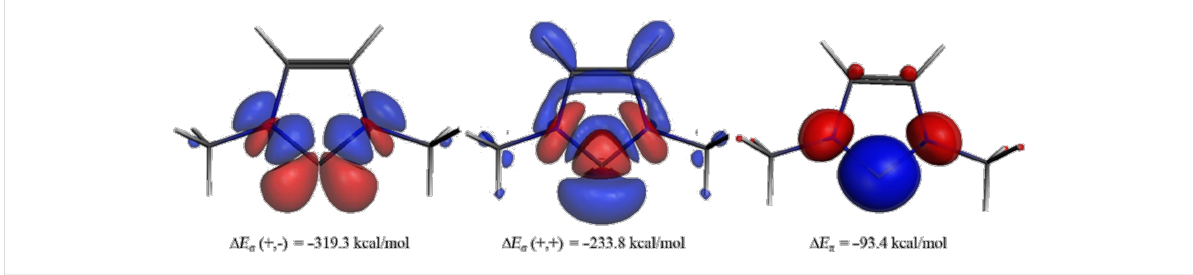
(+, − ) component of the C carb –N σ -bond ( − 319.3 kcal/mol, Figure 3a) is bigger than the ∆ E σ (+,+) component ( − 233.8 kcal/mol, Figure 3b) which can be explained with the larger overlap of the former term (see Scheme 2). Note that the charge flows of the individual (+,+) and (+, − ) interactions have different directions which cannot be easily associated to a phys- ical meaning. It is the net charge flow which indicates the overall direction. The red and blue areas at the carbene carbon in Figure 3b indicates the polarization (change in hybridization) which takes place during the bond formation. The charge flow which is associated with the π -donation X( π ) → C carb shows the expected direction from nitrogen to carbon. The charge flow which is associated with the three dominant orbital interactions in compound 2 – 15 is shown in Figure S1 of Supporting Infor- mation File 1. Figure 4: Plot of the Δ E π values against NBO p π occupation for the